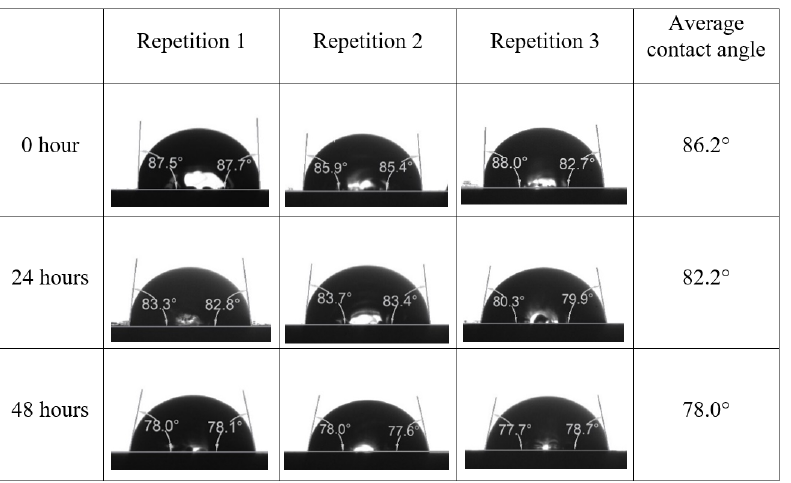
Figure A3. Dynamic Contact Angle Measurement Results for 75% Na 2 SO 4 + 25% CaCl 2 (3500 ppm).